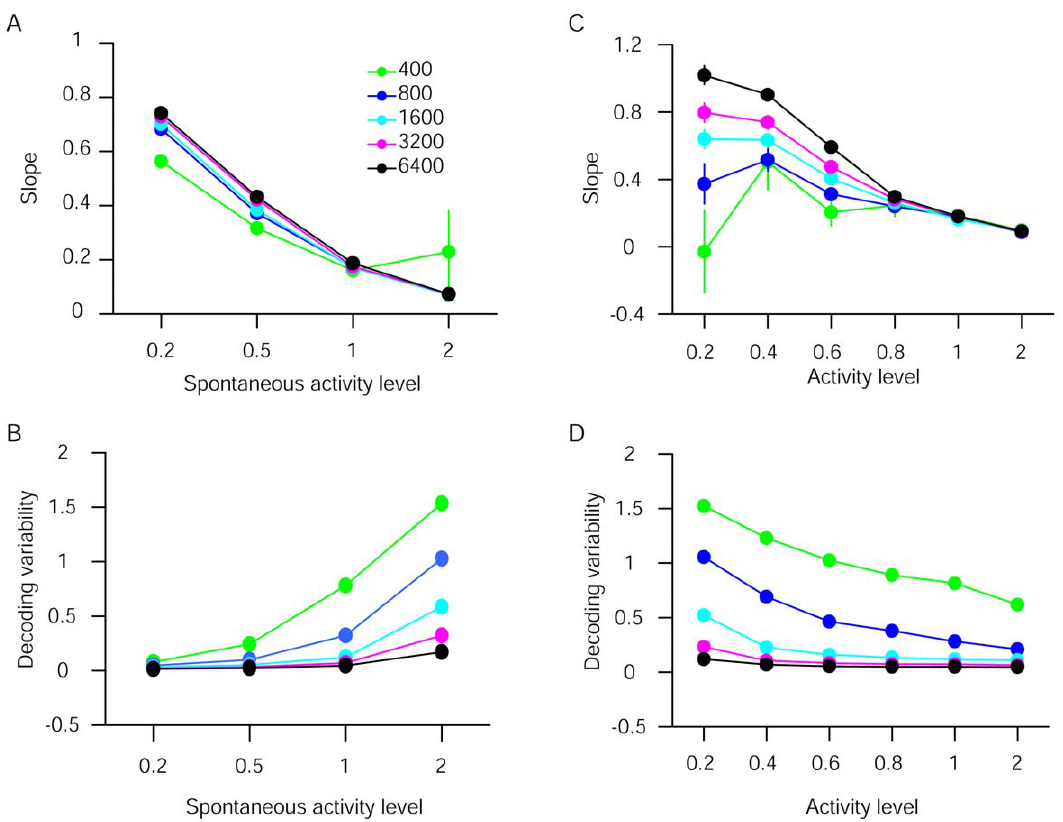
Figure 4. Influence of neuronal population size, baseline activity level, and overall activity level on sensory decoding. ( a and c ) Slopes of the input-output function (see the pink line in Figure 3D), showing the degree of prior bias. ( b and d ) Standard deviation of the decoded frequencies, which measures the decoding variability. In a and b , sensory-evoked activity level was fixed and the neuronal population size (color- coded) and baseline activity level were systematically varied. Baseline activity level refers to the multiplicative factor. For example, baseline activity level of 2 indicates doubling of activity. In c and d , the ratio of baseline activity to maximum evoked response magnitude was set at 1, and activity was systematically varied together. Error bars represent SEM, and are mostly masked by the data symbols.